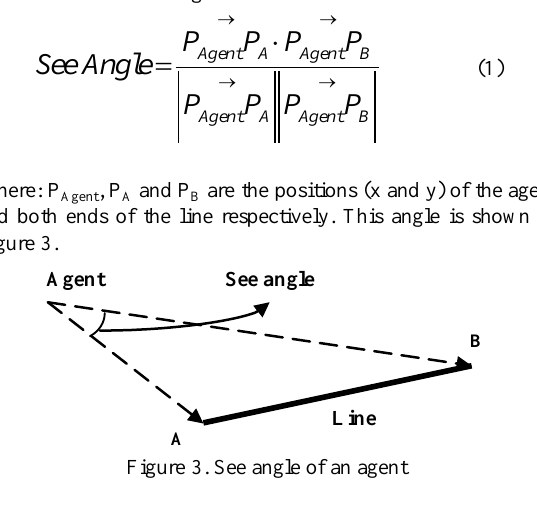
Figure 3. See angle of an agent The locus of all points in the area having the same see angle to the line is a part of a circle as shown in Figure 4. Therefore, another parameter is required to identify the specific object uniquely. The direction of point related to the line is the parameter extracted from the observed data. The direction is calculated by Equation